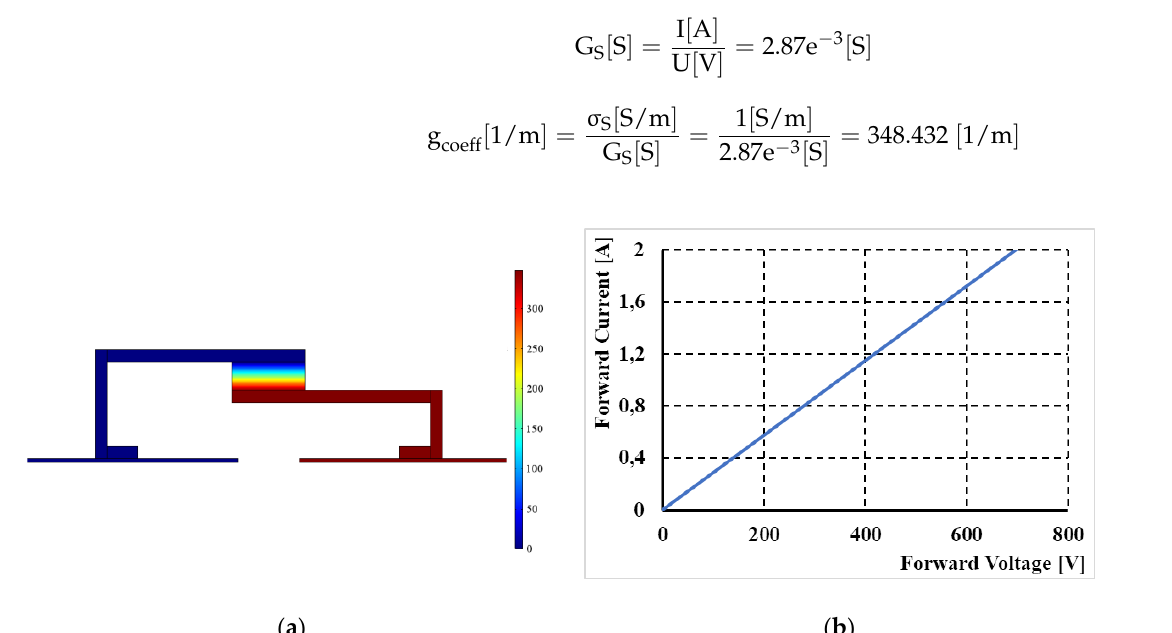
Figure 10. Customized Model Result: ( a ) Forward Voltage for specific current; ( b ) Forward Current dependency on Forward Voltage.